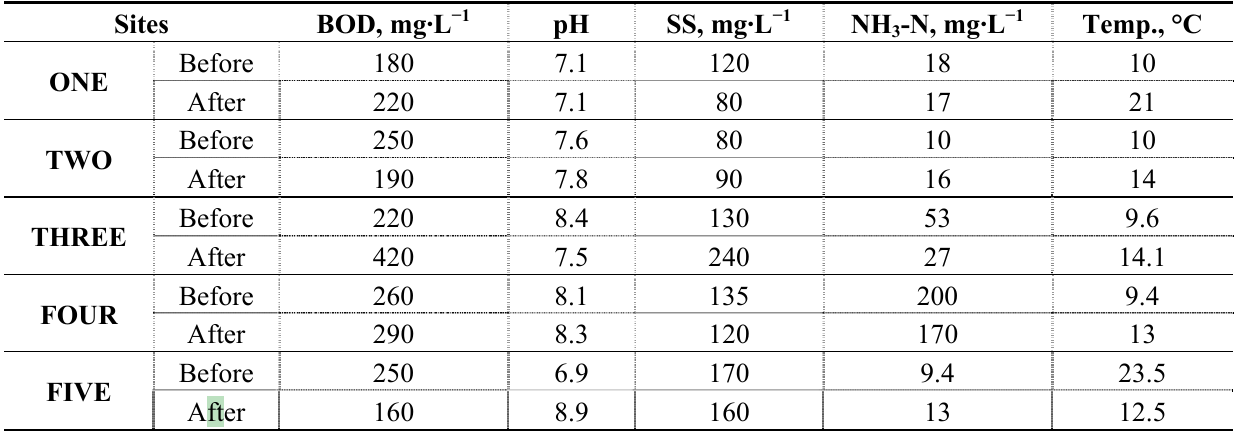
Table 3. Wastewater characteristics before and after treatment with odor-reducing agents at 5